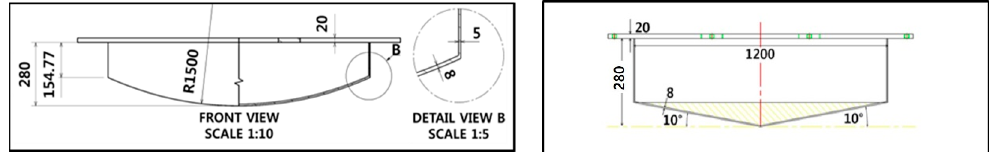
Figure 7. Sectional geometry of the cylindrical model with a deadrise angle of 10°.